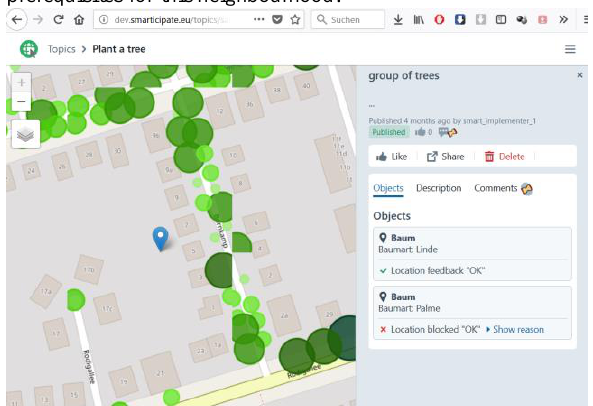
Figure 8. smarticipate Front-End – Desktop View © AIT 2018 Figure 6. smarticipate Back-End – Object Configuration (here: Trees) © AIT 2018